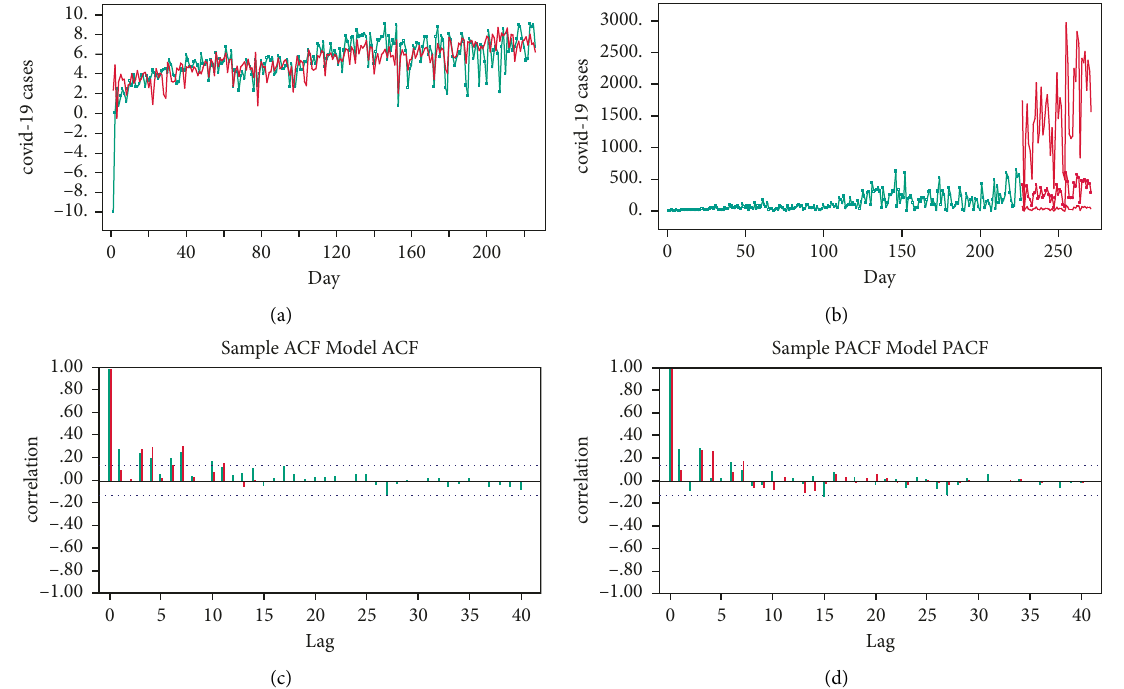
Figure 2: (a) MA (8) estimating the number of COVID-19 cases in Shiraz during February 18th –September 30th 2020; the green dashed line represents the number of observed COVID-19 cases during February 18th –September 30th 2020; the simple red line indicates MA (8) model estimating COVID-19 cases during February 18th –September 30th 2020. (b) MA (8) model predicting COVID-19 cases in Shiraz during October 1st -November 14th 2020; the green line represents the estimated COVID-19 cases during February 18th –September 30th 2020; the red line represents the predicted COVID-19 cases during October 1st -November 14th 2020 with its confidence interval. (c) Sample/model MA (8) auto correlation function (ACF) and (d) partial auto correlation function (PACF) for Shiraz during October 1st -November 14th 2020; the green correlations are derived from the sample and the red correlations are taken from the fitted model; two dashed horizontal lines are confidence bands; a model is considered good in case the sample and model correlations out of the bands overlap. Table 6: The spatiotemporal outbreaks of the 55 369 COVID-19 cases in Fars province, Iran during 1 October–14 November 2020. Radius Canon Cluster Location statistic (km) Cluster 1 Cluster 2